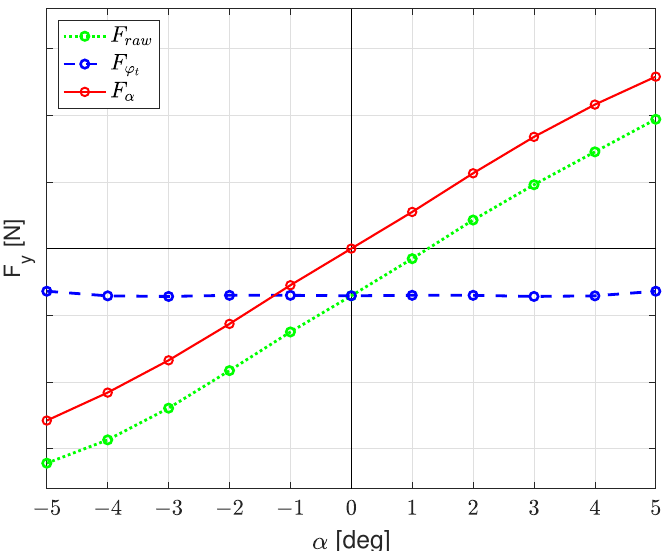
Figure 2. Example of a pure sideslip measurement. The dotted green curve is the raw tyre lateral force, the red solid line is the sideslip-related force obtained with the application of (4), while the blue dashed line is the turn slip force obtained as the difference between raw force and sideslip force. Note that, at zero sideslip, the dotted green and dashed blue curves coincide, as expressed by